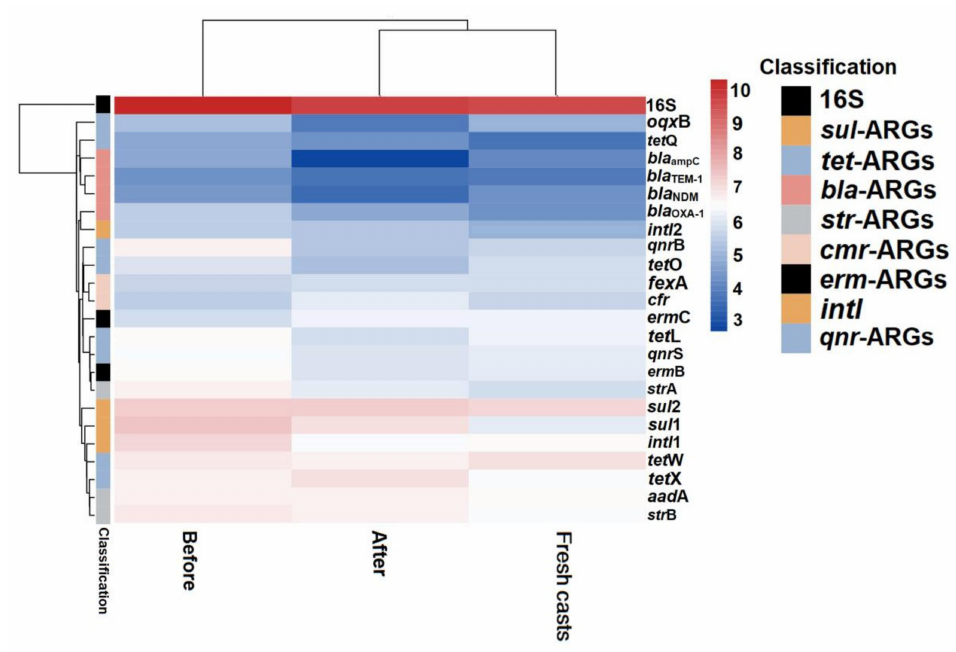
Figure 4. Concentrations of resistance genes before and after transformation of earthworms without added